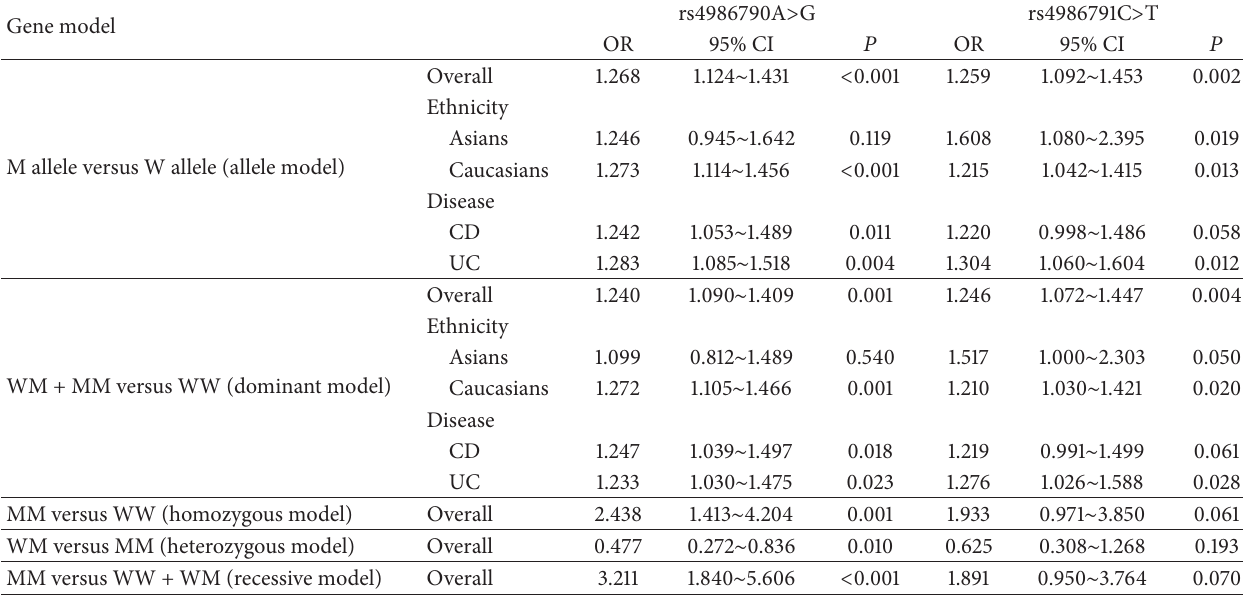
Table 3: Comparisons of genotype and allele frequencies between the case and the control groups.